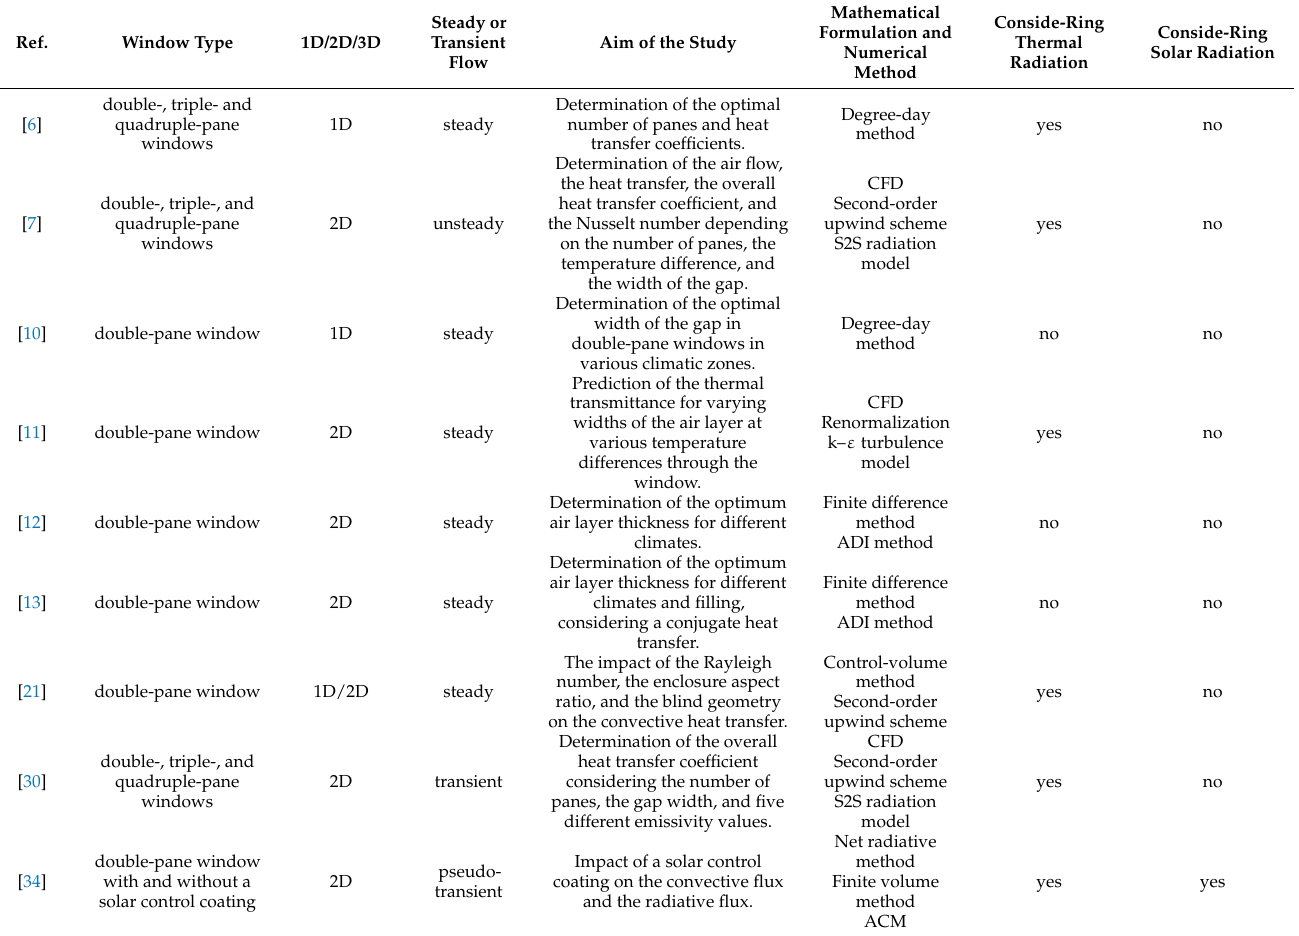
Table 1. Overview of the topically relevant numerical investigations of heat transfer in windows.